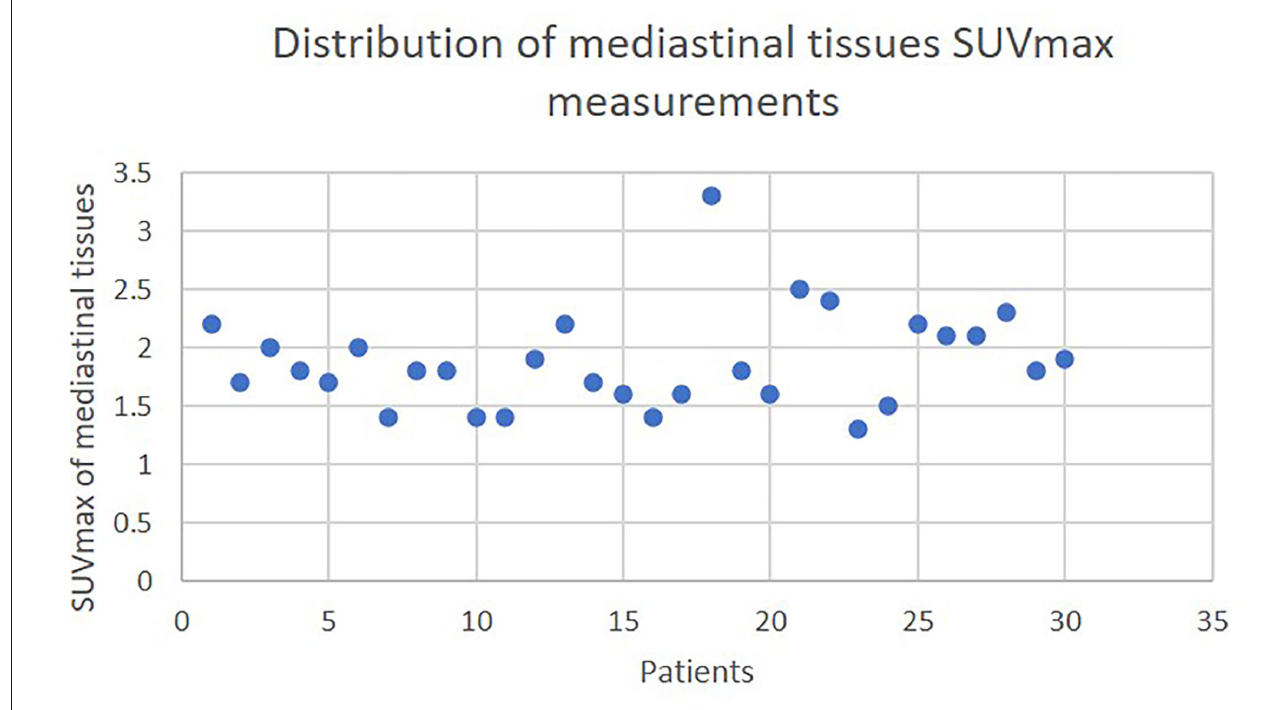
FIGURE 2 | The distribution of mediastinal tissue